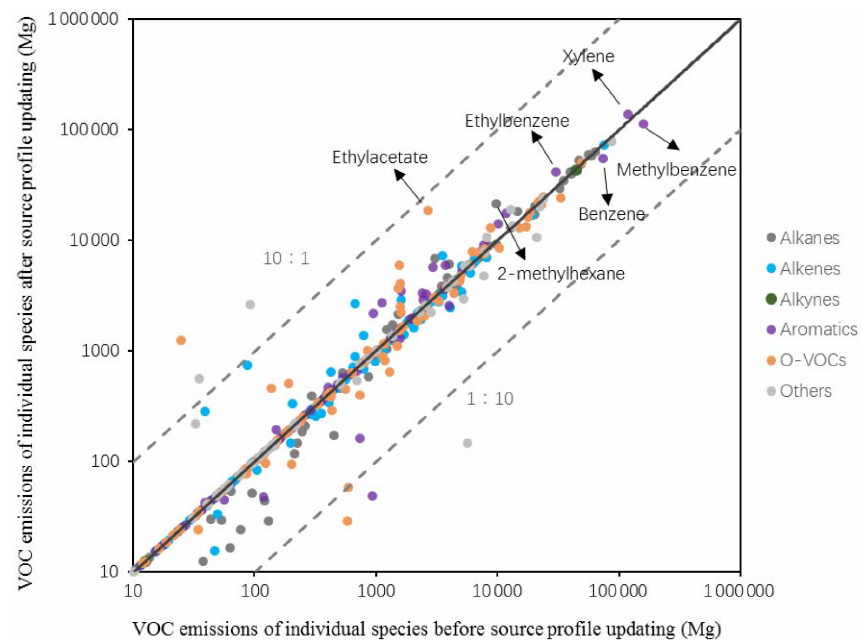
Figure 6. Emissions of NMVOC species for Jiangsu in 2010 before and after source profile